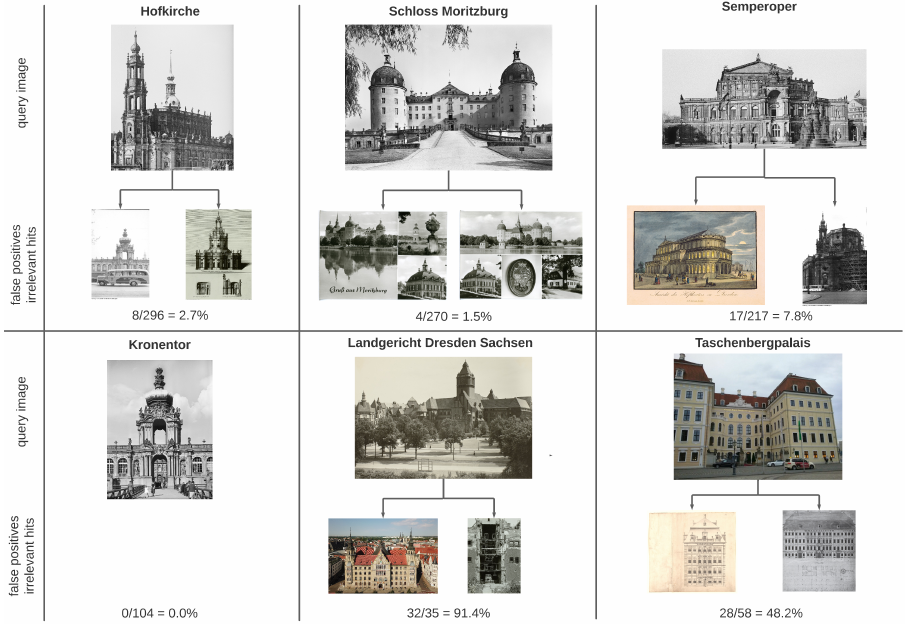
Figure 14. Metadata search tag and query image for six different landmarks in the vicinity of Dresden. Below every landmark, two examples and the absolute number of false positives re- trieved by LEA are given. An especially high number of false positives can be seen for the smaller Landgericht and Taschenbergpalais datasets. These occur because there are no other relevant hits in the image repository.